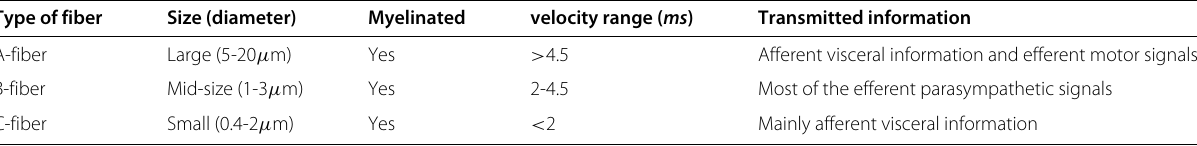
Fig. 1 The Vagus Nerve and the Inflammatory Reflex (Pavlov et al. 2020) Table 1 Characterization of vagus nerve